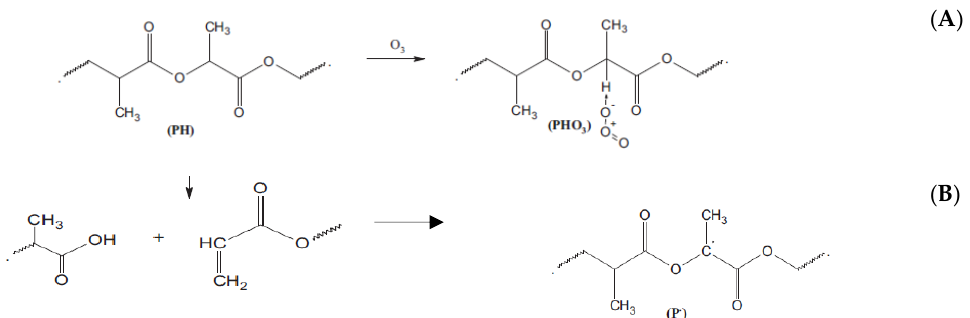
Figure 4. The scheme of polyester (PLA) ozonolysis. Two principal consecutive reactions of pendant groups’ formation ( A ) and the chemical rupture of the polymer chain ( B ) — advanced by [34].